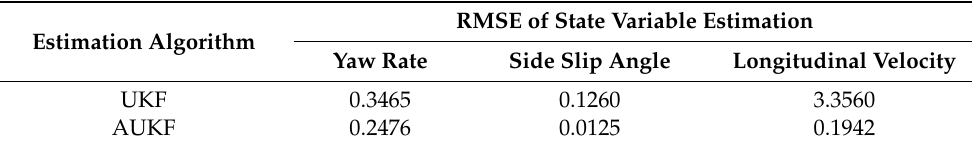
Table 4. RMSE of the two algorithms during the entire duration of the process. Estimation